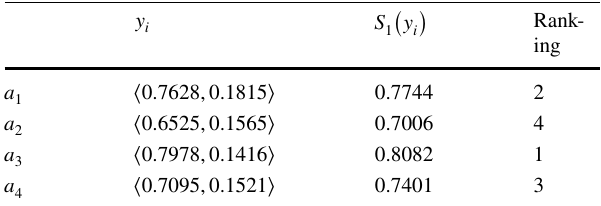
Table 9 Ranking by the PF-RS approach